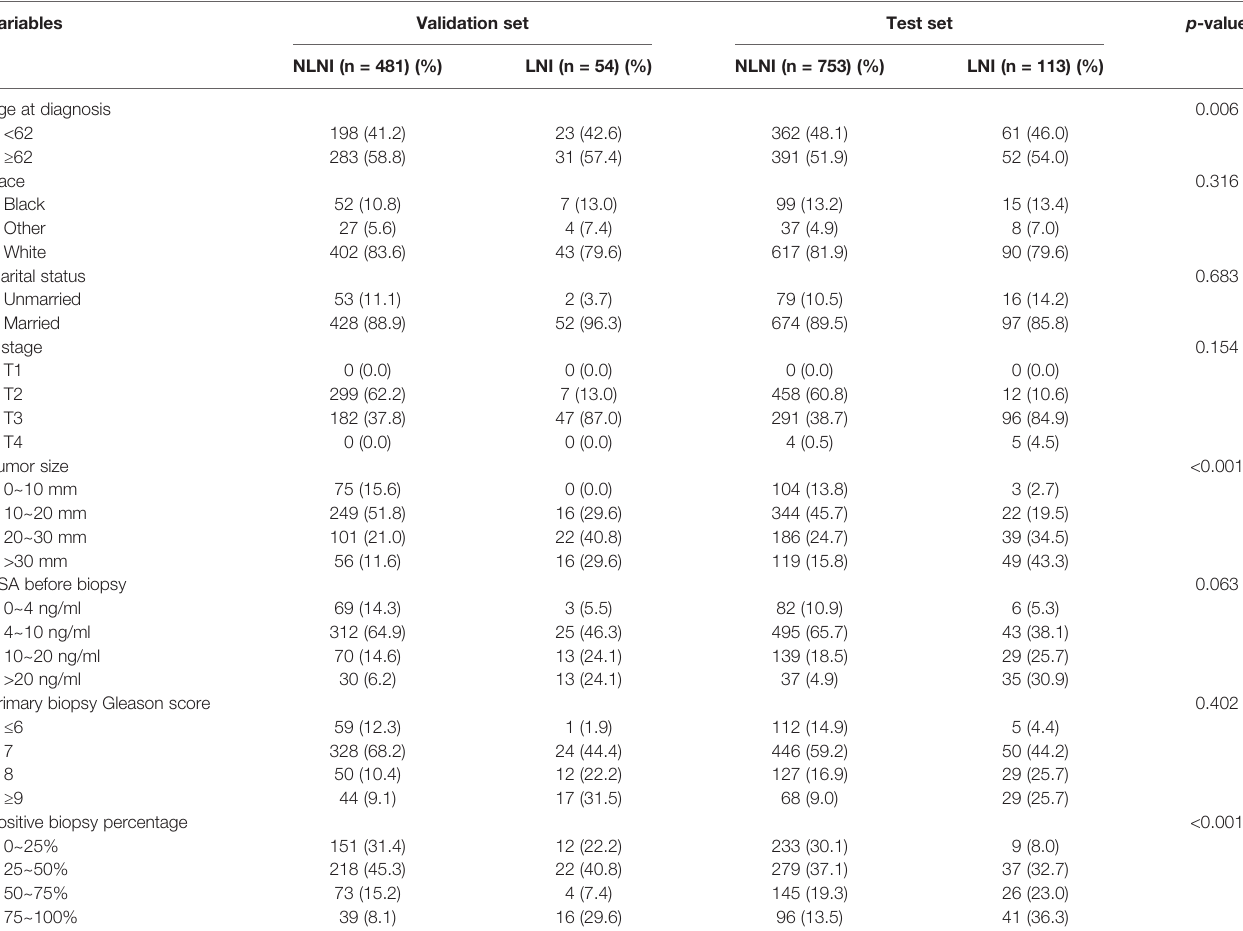
TABLE 4 | Clinical and pathological characteristics of the test and validation sets. Variables Validation